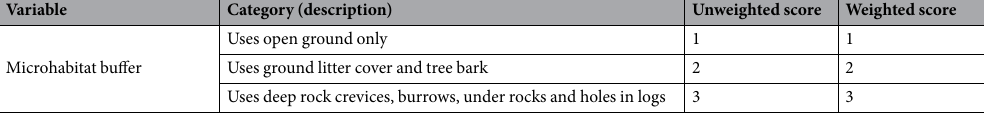
Table 1. Description of the variable categories and their scores for the three elements of climate change vulnerability as applied to assess the vulnerability of 17 lizards along the Great Dividing Range of Australia (for references see Supporting Information Tables S4 and S5). For geographic range size, N refers to the number of 100 × 100 km grid cells occupied by the